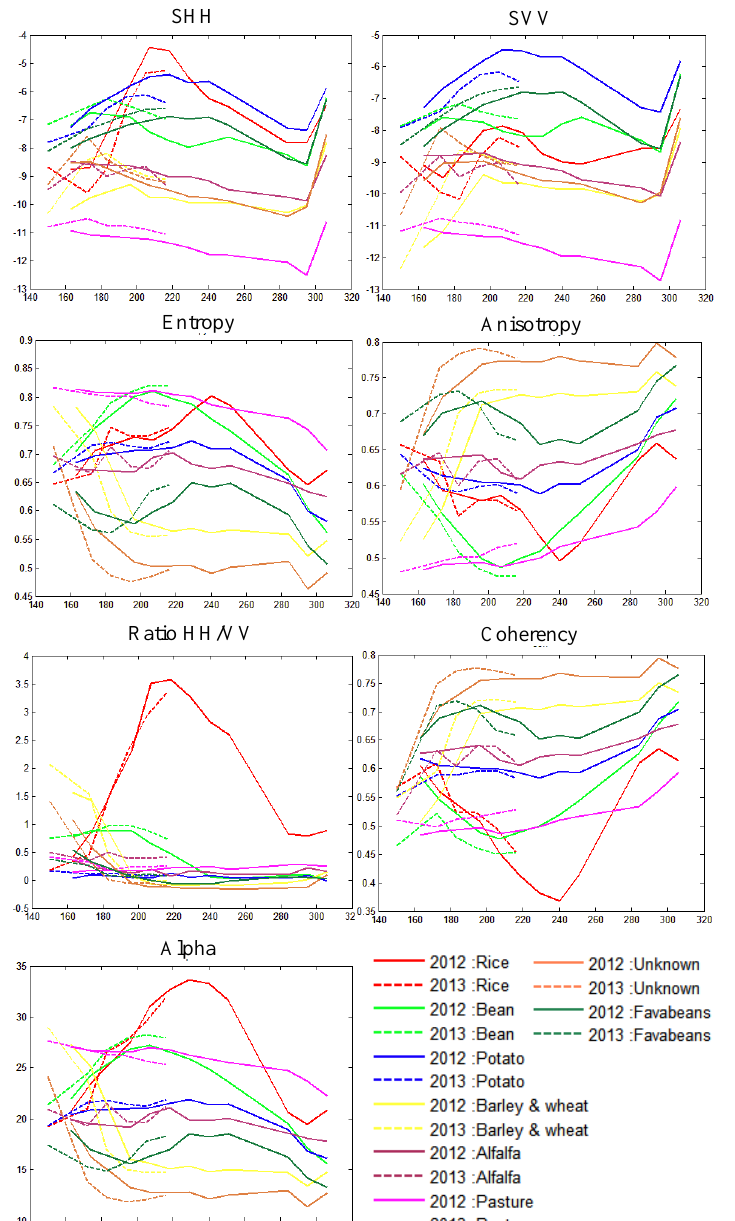
Figure 7: Temporal signature of all classes in each feature over an agricultural